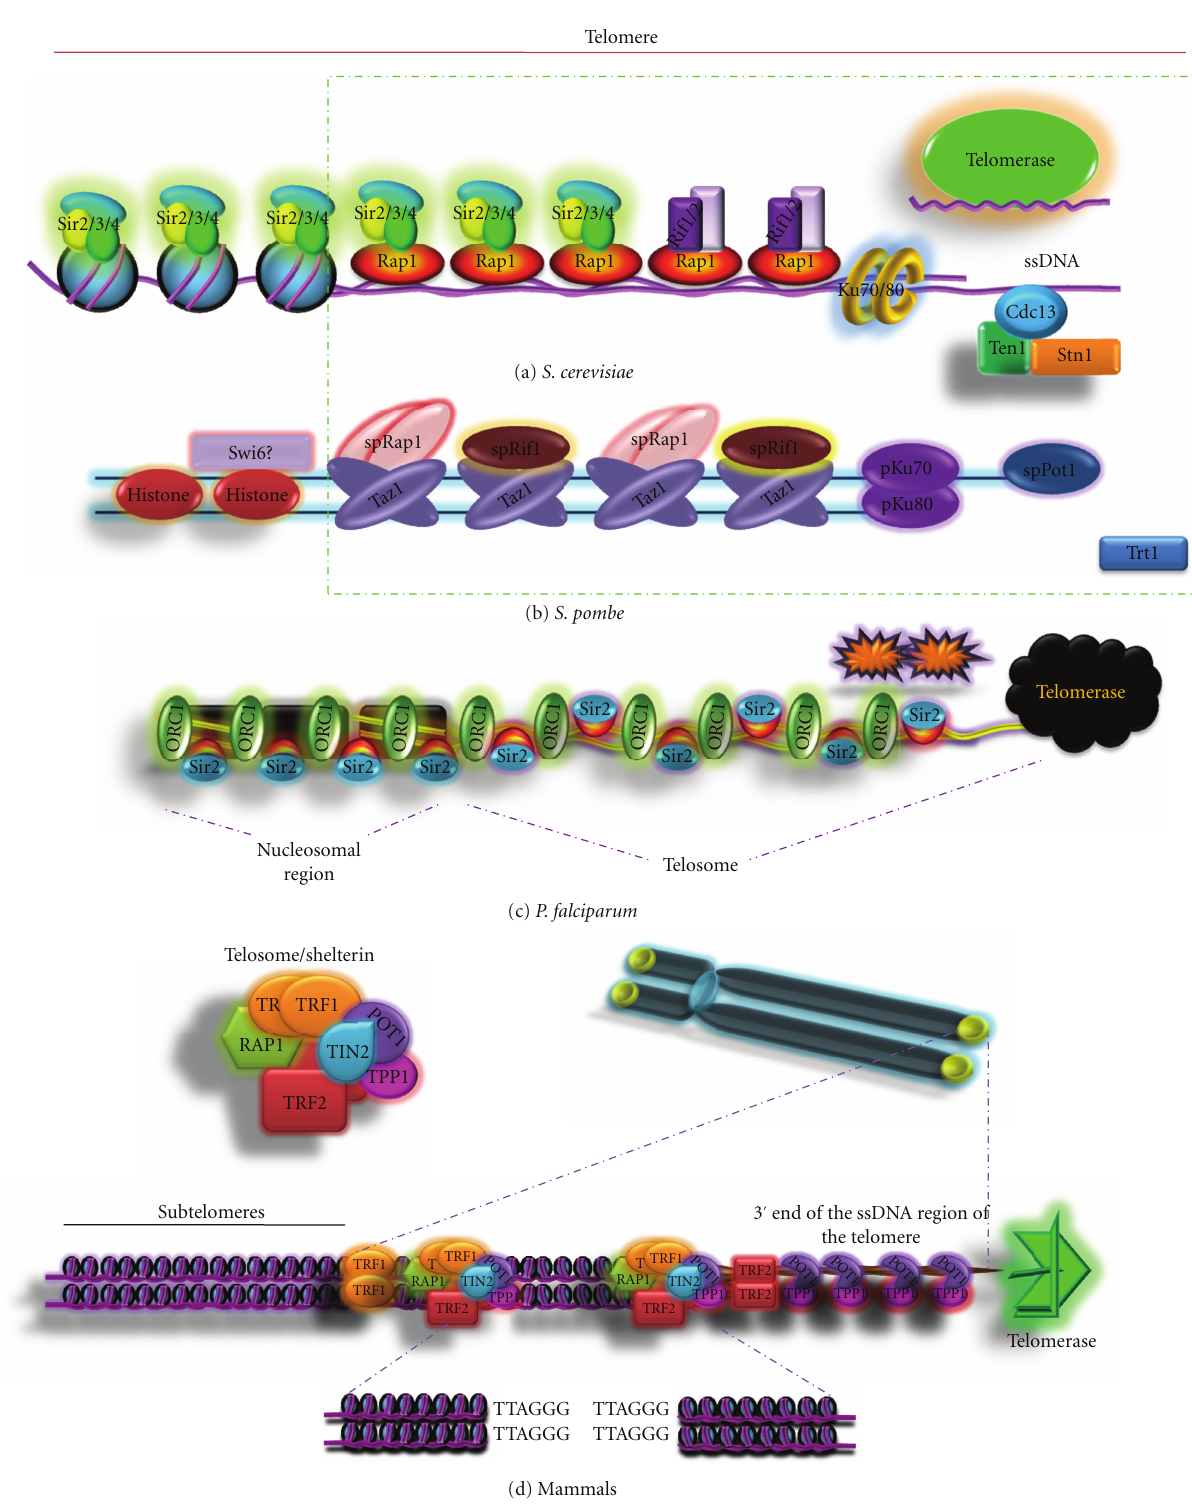
Figure 2: Hetrochromatin in S. cerevisiae, S. pombe, P. falciparum and